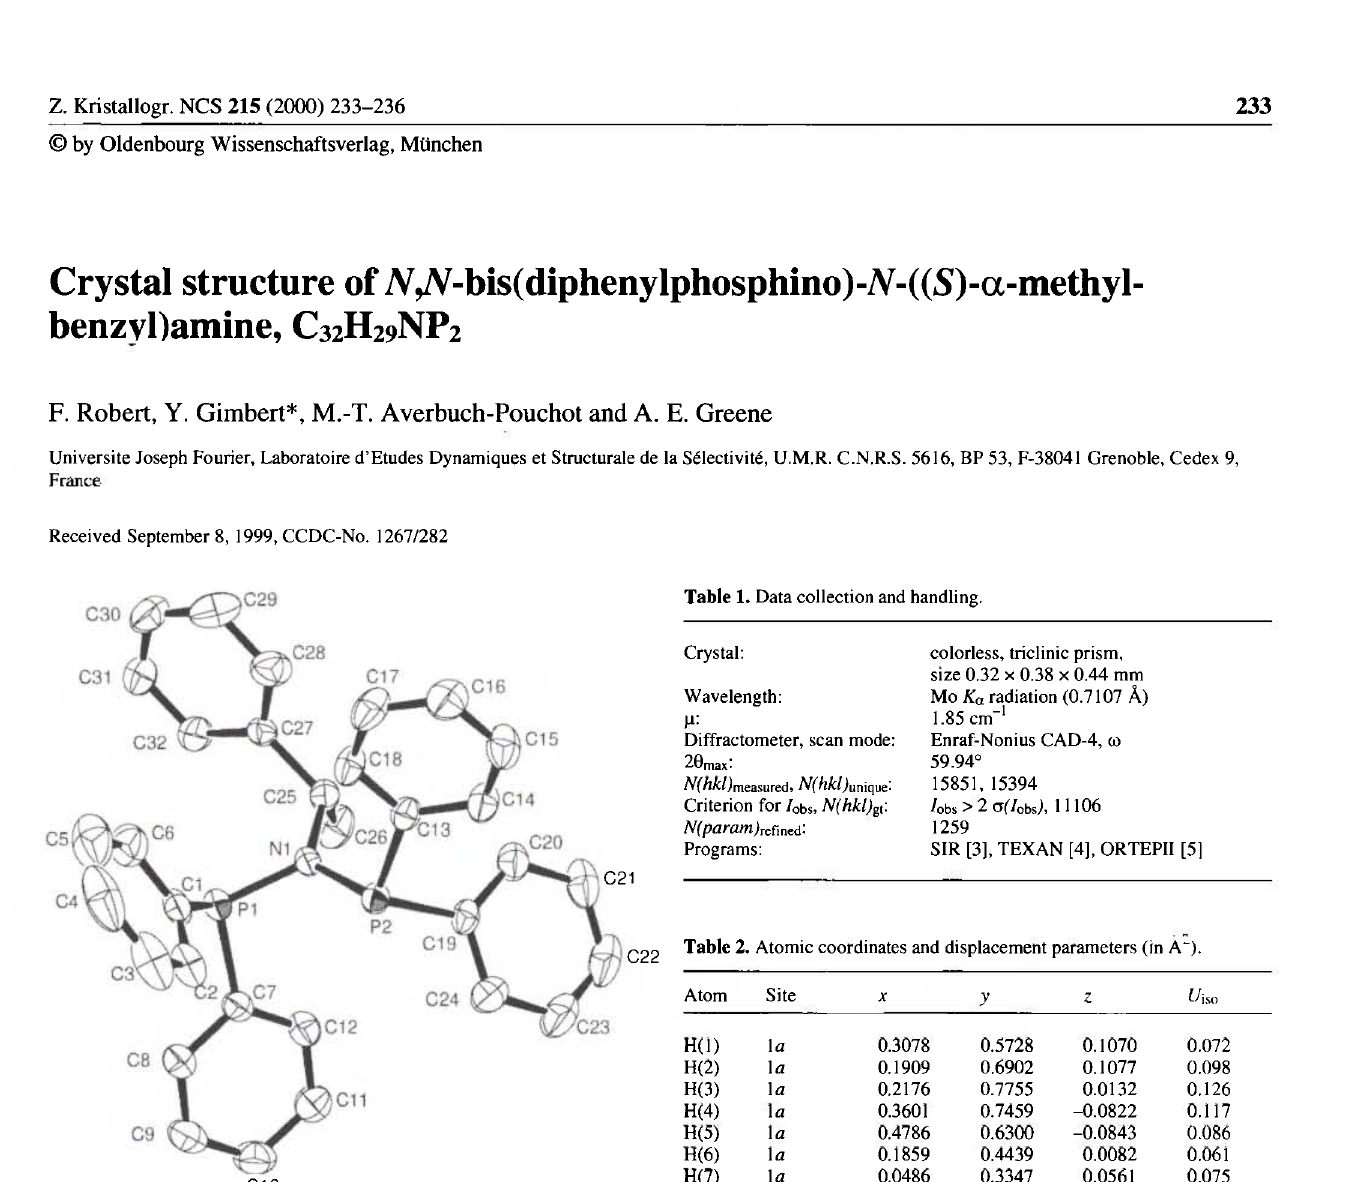
Table 2. Atomic coordinates and displacement parameters (in